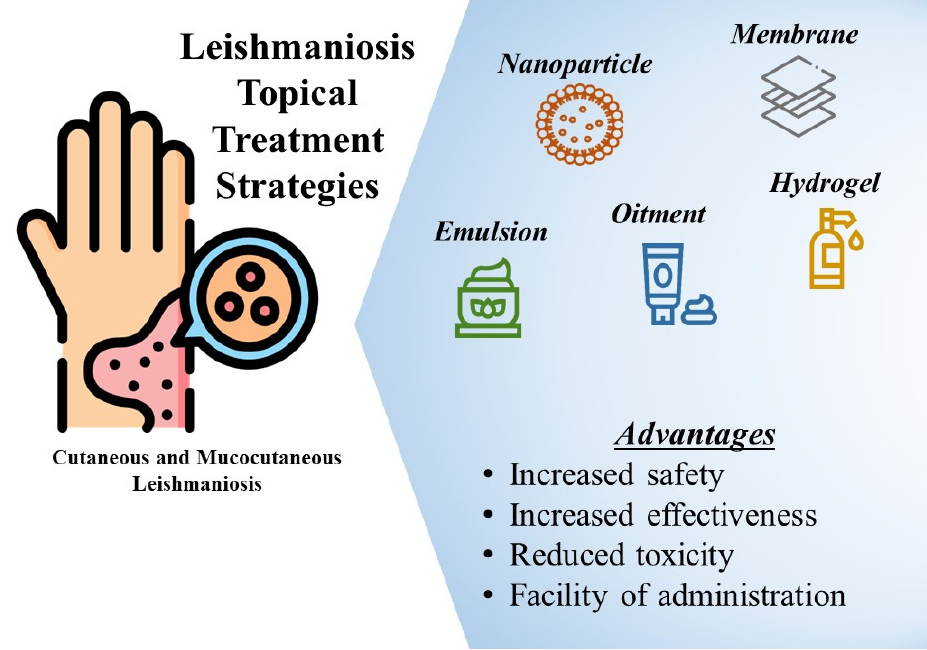
Figure 1. Examples of topical strategies for the treatment of cutaneous and mucocutaneous Leish- maniosis and their advantages.